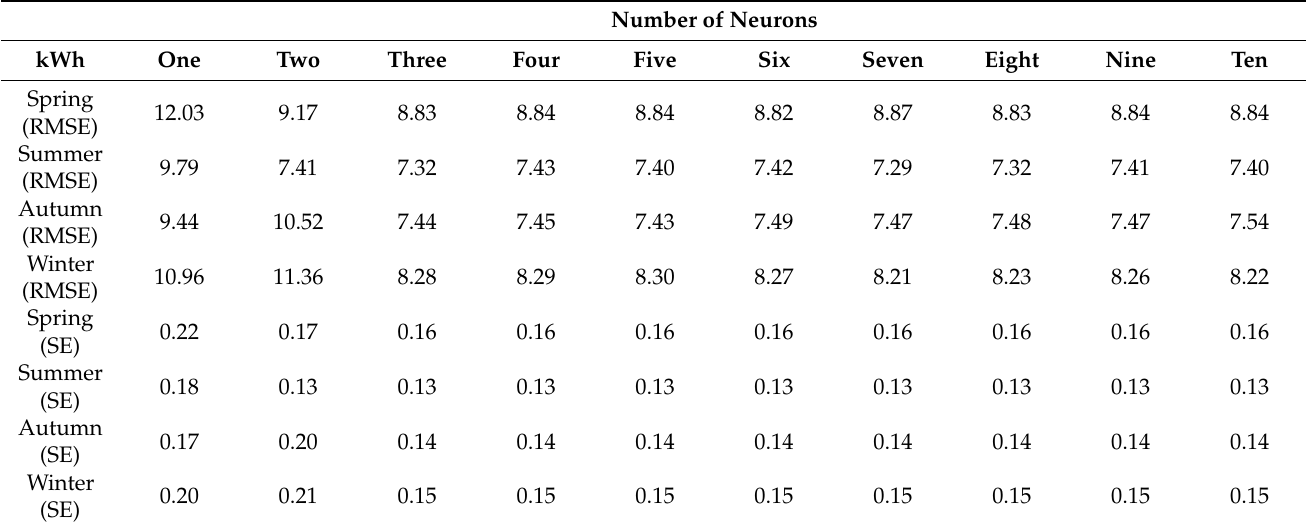
Table A1. The impact of altering the number of neurons on the ANN monthly predictions’ RMSE and SE. Number of Neurons